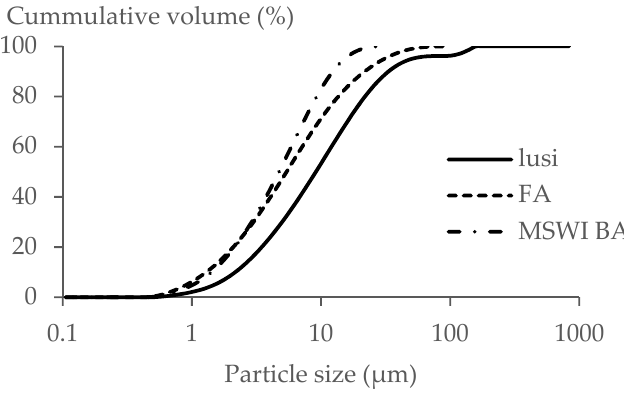
Figure 2. Particle size distribution. Table 4. Quantitative X-Ray Diffraction of municipal solid waste incineration bottom ash (MSWI BA), fly ash (FA), and Lusi.